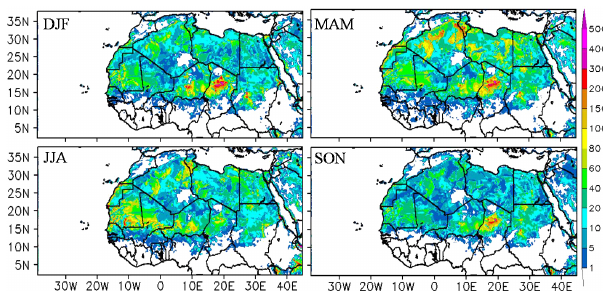
Figure 4. Seasonal mean aerosol dust emissions simulated by AL- ADIN (ingm − 2 ) over northern Africa averaged for the 2006–2010 period.